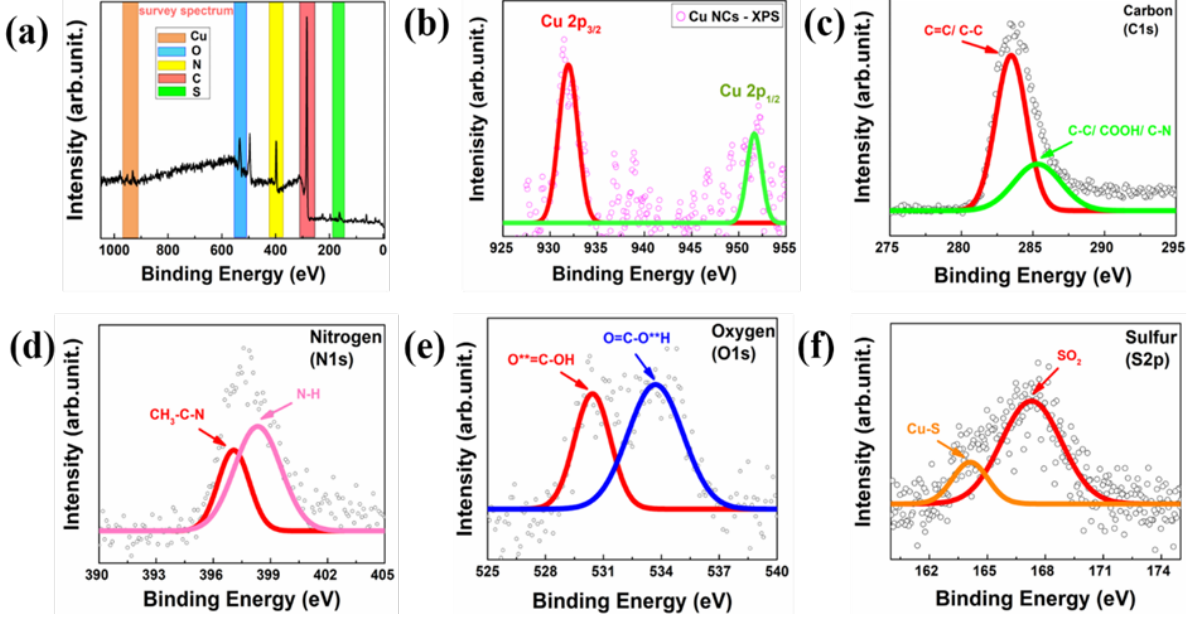
Figure 2. The XPS analysis of BSA-Cu NCs. ( a ) The existence of C, N, O, S and Cu elements in the protein-mediated Cu NCs was confirmed by the full survey scan. ( b ) High-resolution XPS revealed the presence of Cu 2p 3/2 and 2p 1/2 binding energies ascribed to the zero (red line) and monovalent (green line) oxidation states of Cu NCs. ( c ) C1s element shows two distinct peaks, which represent C=C or C-C (red line) and C-C/COOH/ C-N (green line), respectively. ( d ) N1s element showed two peaks, CH 3 CN (red line) and NH 3 (pink line). ( e ) O1s element confirms the presence of O**=C-OH (red line) and O=C-O**H (blue line). ( f ) S2p element observed multiple peaks corresponding to sulfur copper (Cu-S) (yellow line) and oxidized sulfur (SO 2 ) (red line). The NIST-XPS database was utilized to validate the bonds for different BE values, and the black dots in all the pictures ( b – f ) represent the experimental results.